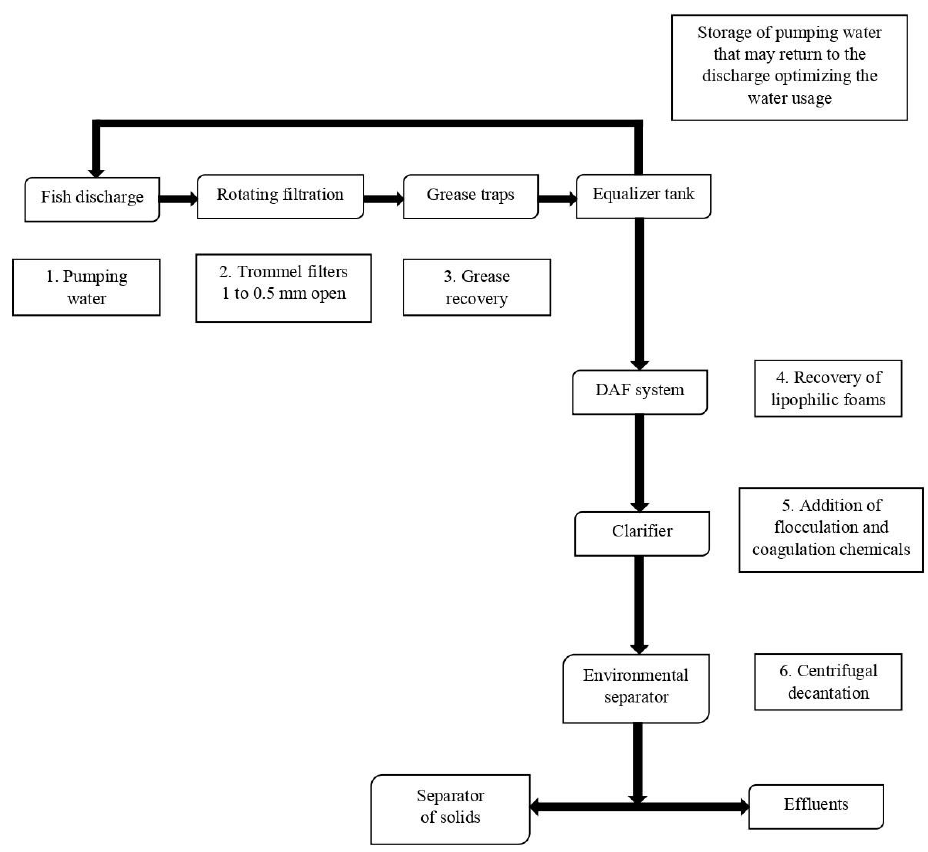
Figure 1. Scheme for the fish PW treatment system. Source: Pesquera Diamante.